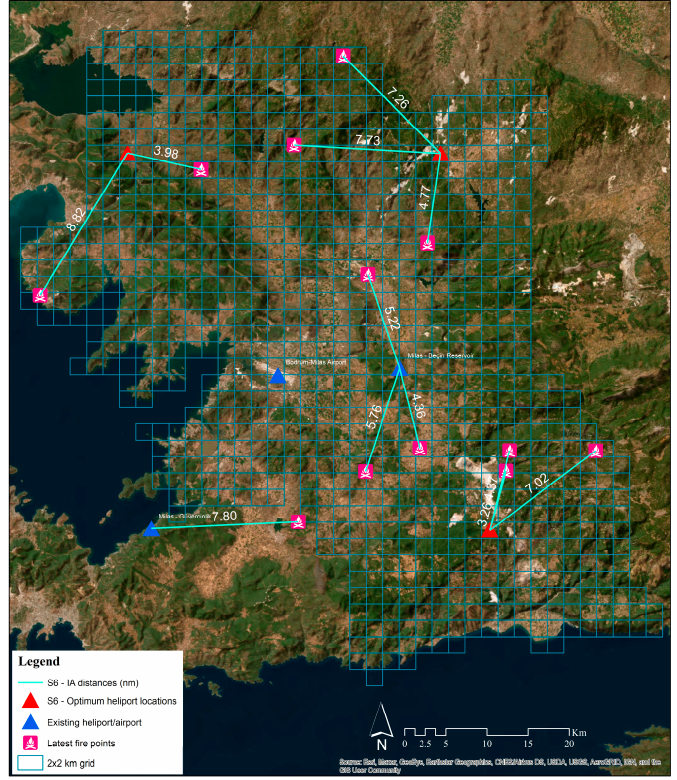
Figure 23. IA times in s6.